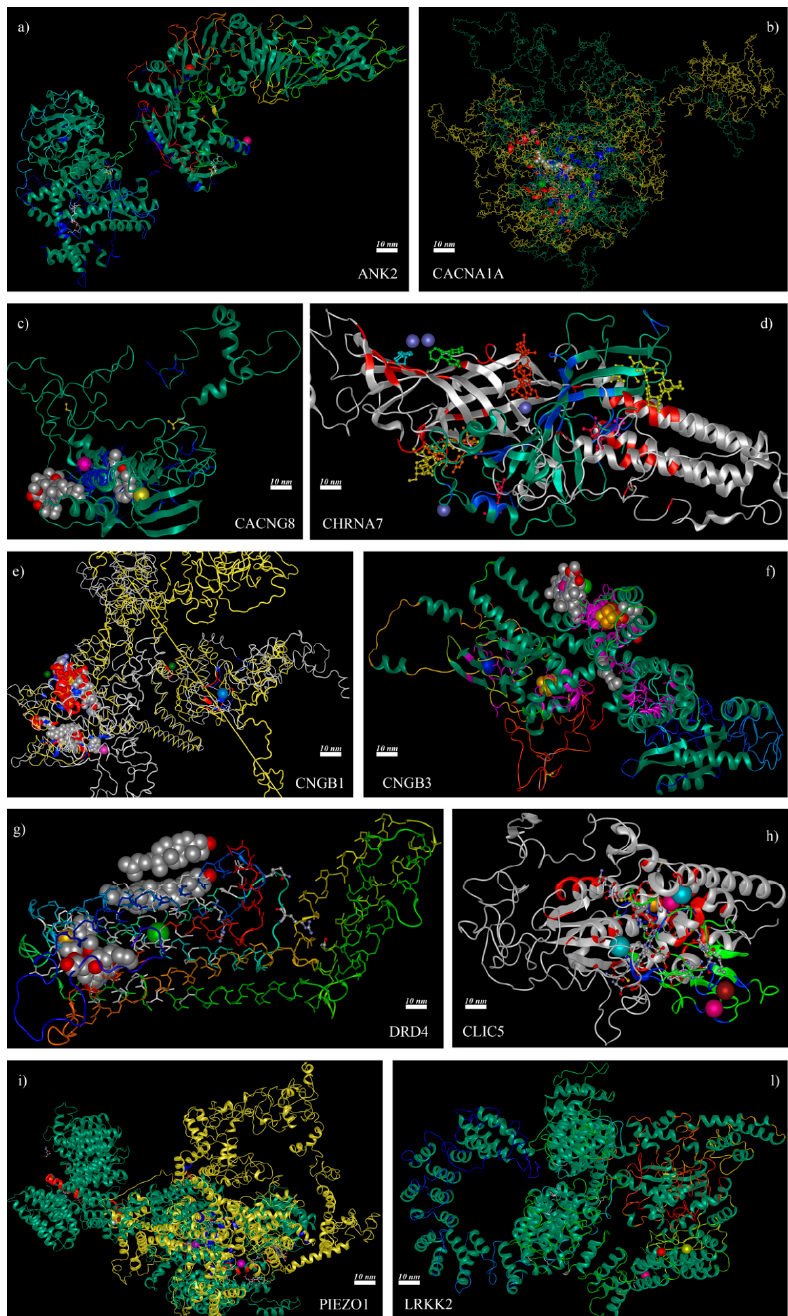
Figure 1. 3D structural analysis of mutated channels or related proteins encoded by candidate genes. The mixed analysis of NovaFold and Protean 3D permitted evaluation of the alteration of binding sites in mutated ion channels or related proteins. Each box represents the alignment of wild-type and mutated forms of each considered predicted protein structure. Blue ribbons = mutated binding sites, red ribbons = wild-type binding sites. ( a ) Red sphere = Ca 2+ , light purple sphere = Mg 2+ . ( b ) Green sphere = Ca 2+ , dark purple sphere = Mg 2+ , ( c ) Yellow sphere = Ca 2+ , light purple sphere = Zn 2+ . ( d ) Dark purple = NH 2 . ( e ) Green sphere = Mg 2+ , blue sphere = K + , light purple sphere = Ca 2+ . ( f ) Green sphere = Ca 2+ . ( g ) Green sphere = Na + . ( h ) Turquoise sphere = Ca 2+ , yellow sphere = Fe 2+ , light purple sphere = Mn 2+ , red sphere = Zn 2+ . ( i ) Light purple sphere = Ca 2+ , pearl grey = Mg 2+ . ( l ) Yellow sphere = Ca 2+ , light purple sphere = Mg 2+ , Red sphere =